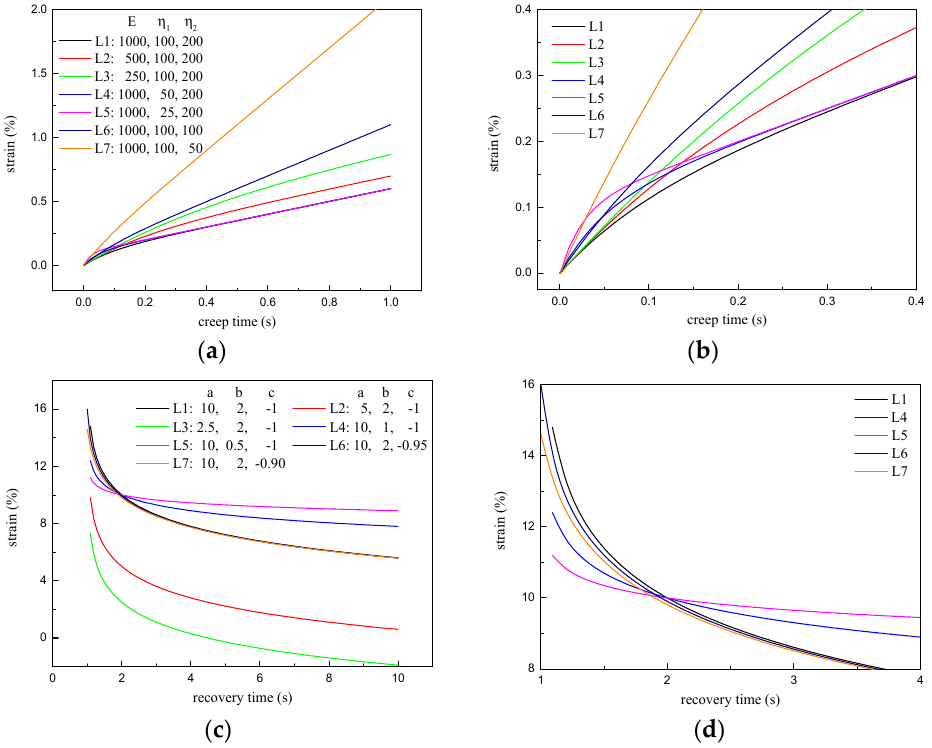
Figure 15. Response of creep − recovery curves to model parameters: ( a ) Three − element model for